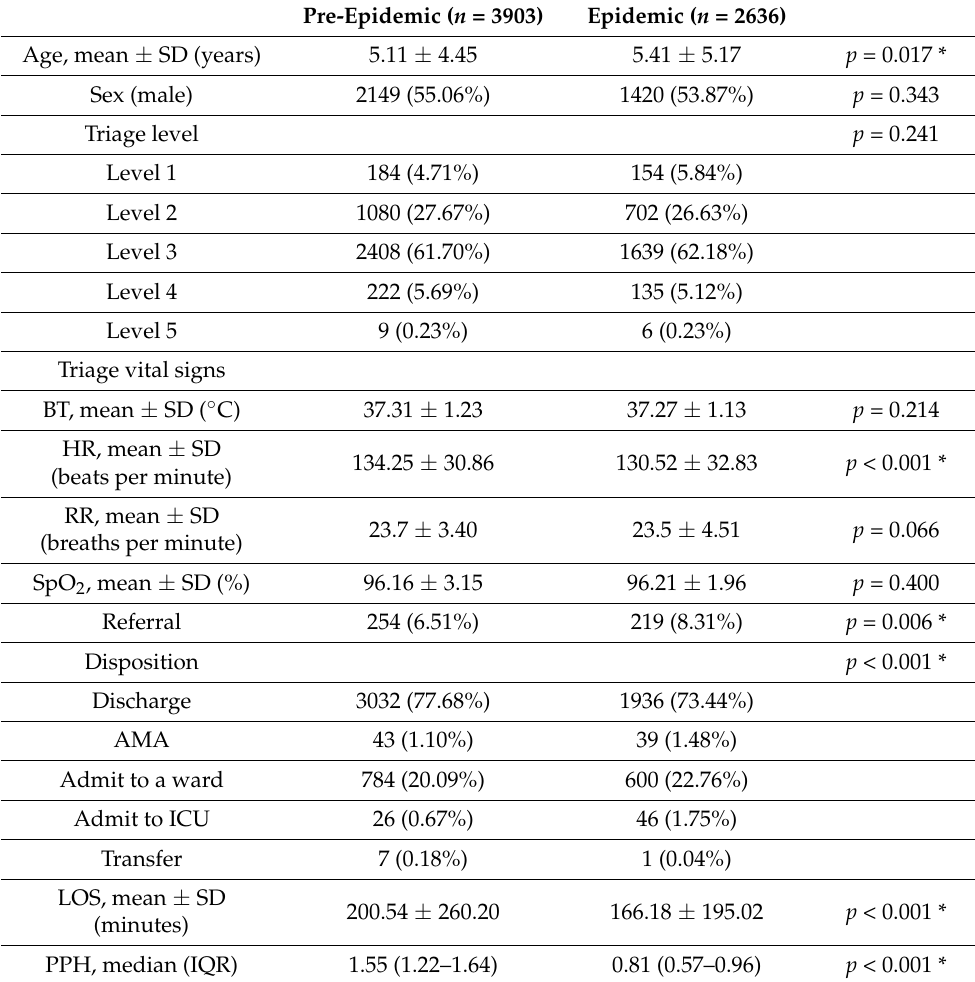
Table 1. Characteristics of the pediatric patients seen by EM residents in the pre-epidemic and epidemic